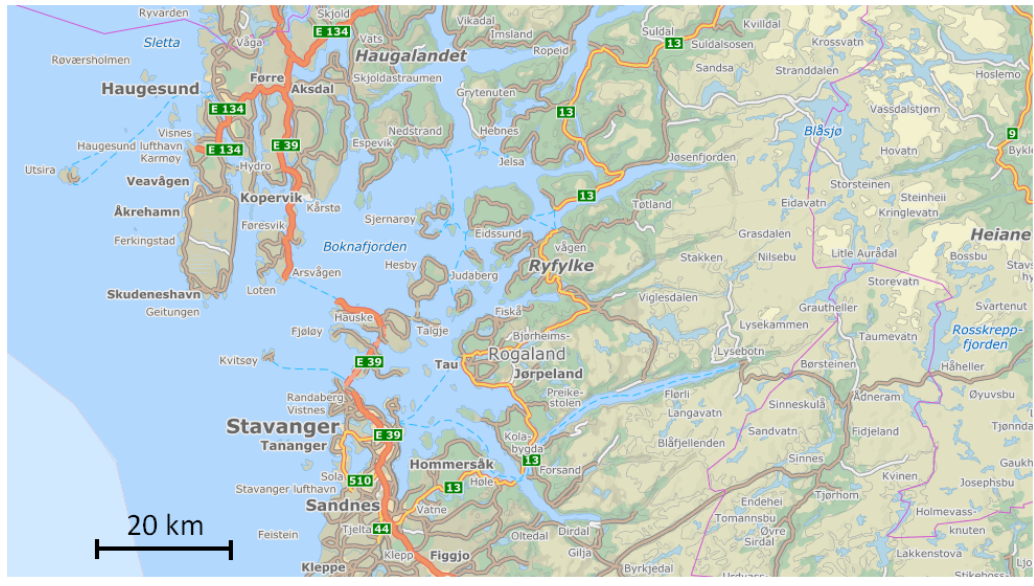
Figure 9. Map of the fjord Boknafjorden between Haugesund and Stavanger, Norway. North up on the map. (Accessible for free from www.norgeibilder.no).